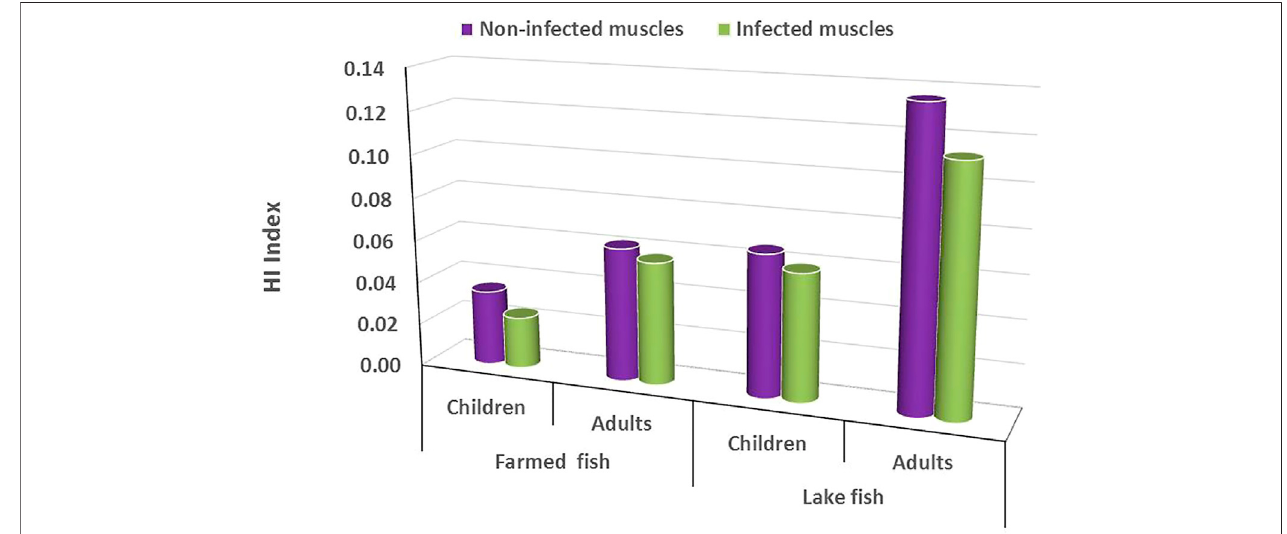
FIGURE 6 | Hazard index (HI) for heavy metals in the muscles of lake and farmed Nile Tilapia, O. niloticus .